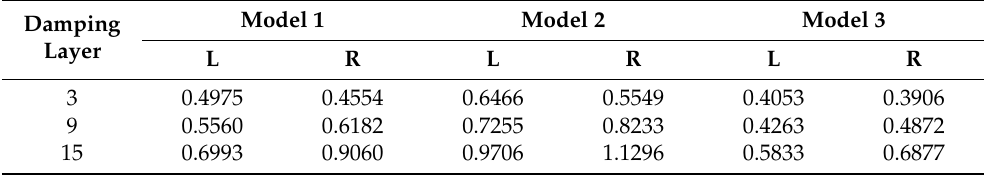
Table 5. Damping effects for the base shear